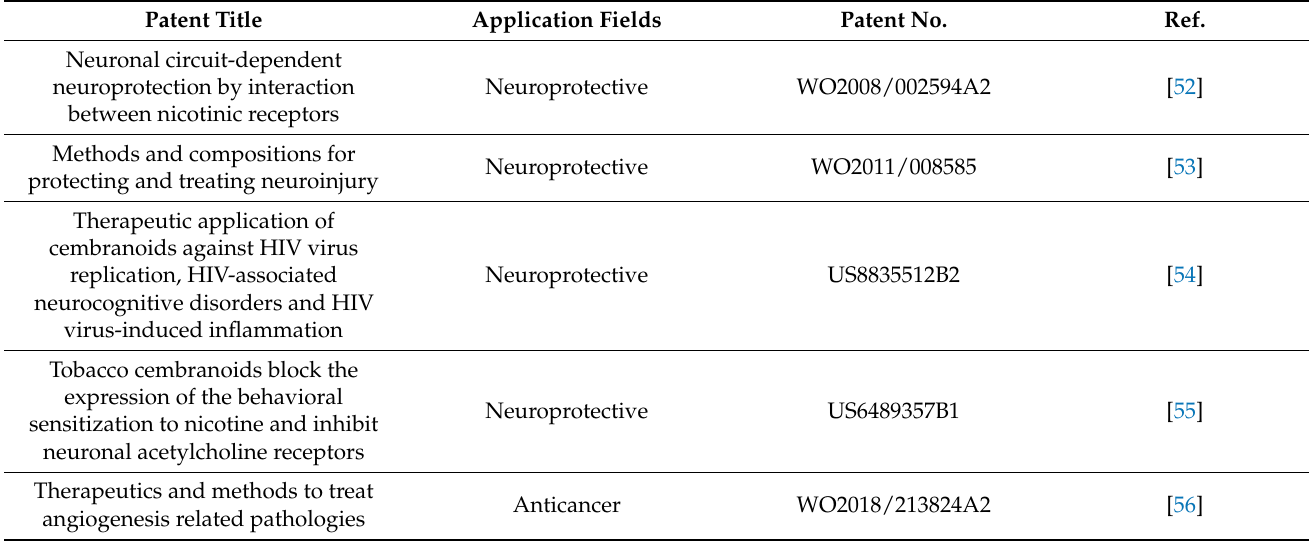
Table 1. Published and granted patents related to α - and β -CBD and their semisynthetic